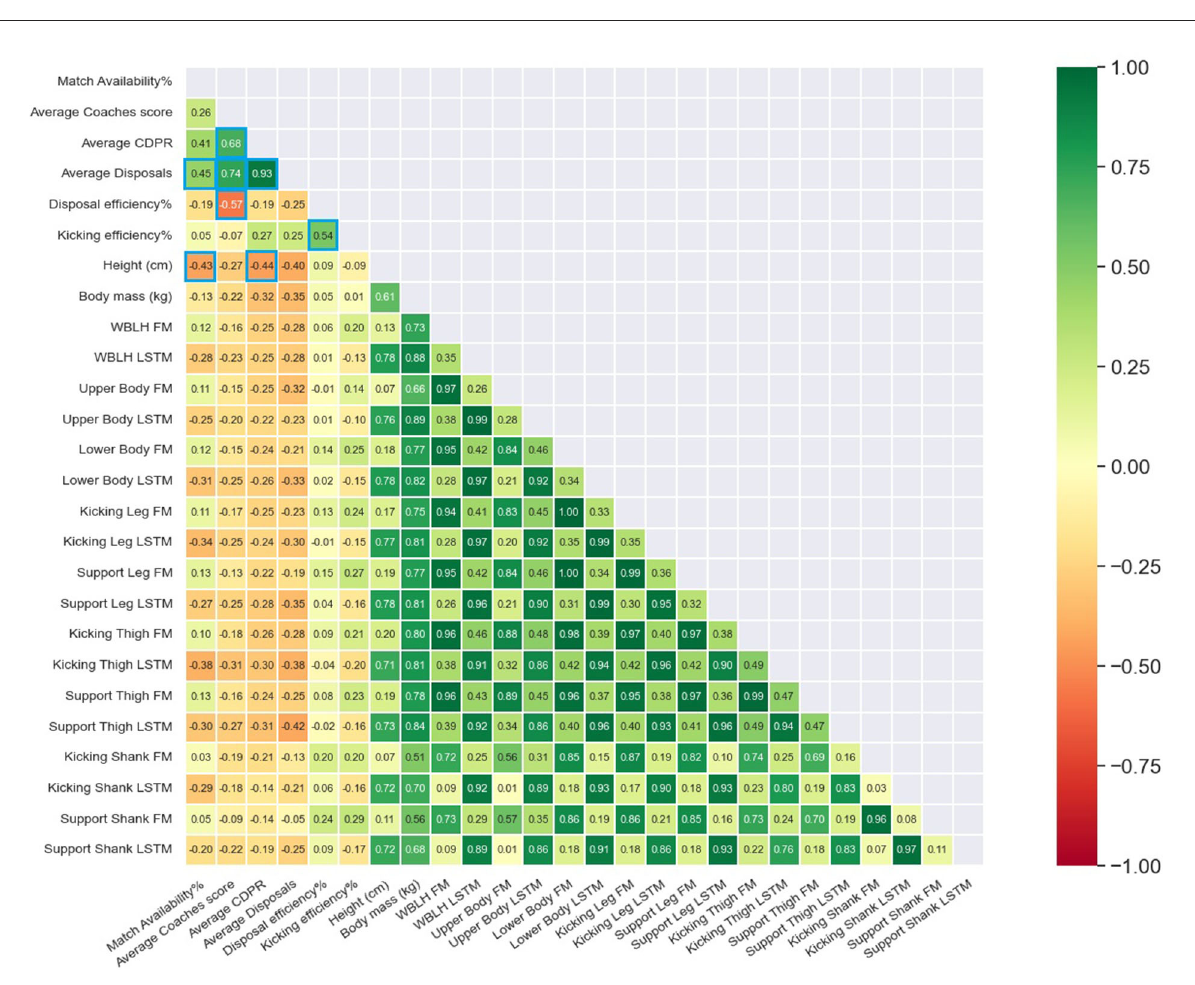
FIGURE2 Pearson correlation matrix examining the association between pre-season body composition characteristics expressed as absolute values, and in-season match availability and match performance. Significant (p ≤ 0.05) relationships are represented by blue boxes. CDPR, Champion Data Player Rank; LSTM, Lean soft-tissue mass; UB, Upper body; LB, Lower body; FM, fat